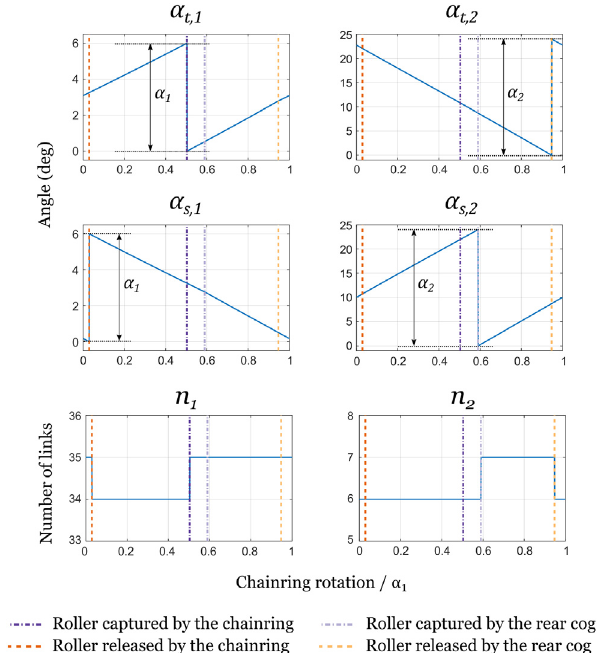
Fig. 15. Evolution of the main kinematic parameters for the 60| 15 drive.